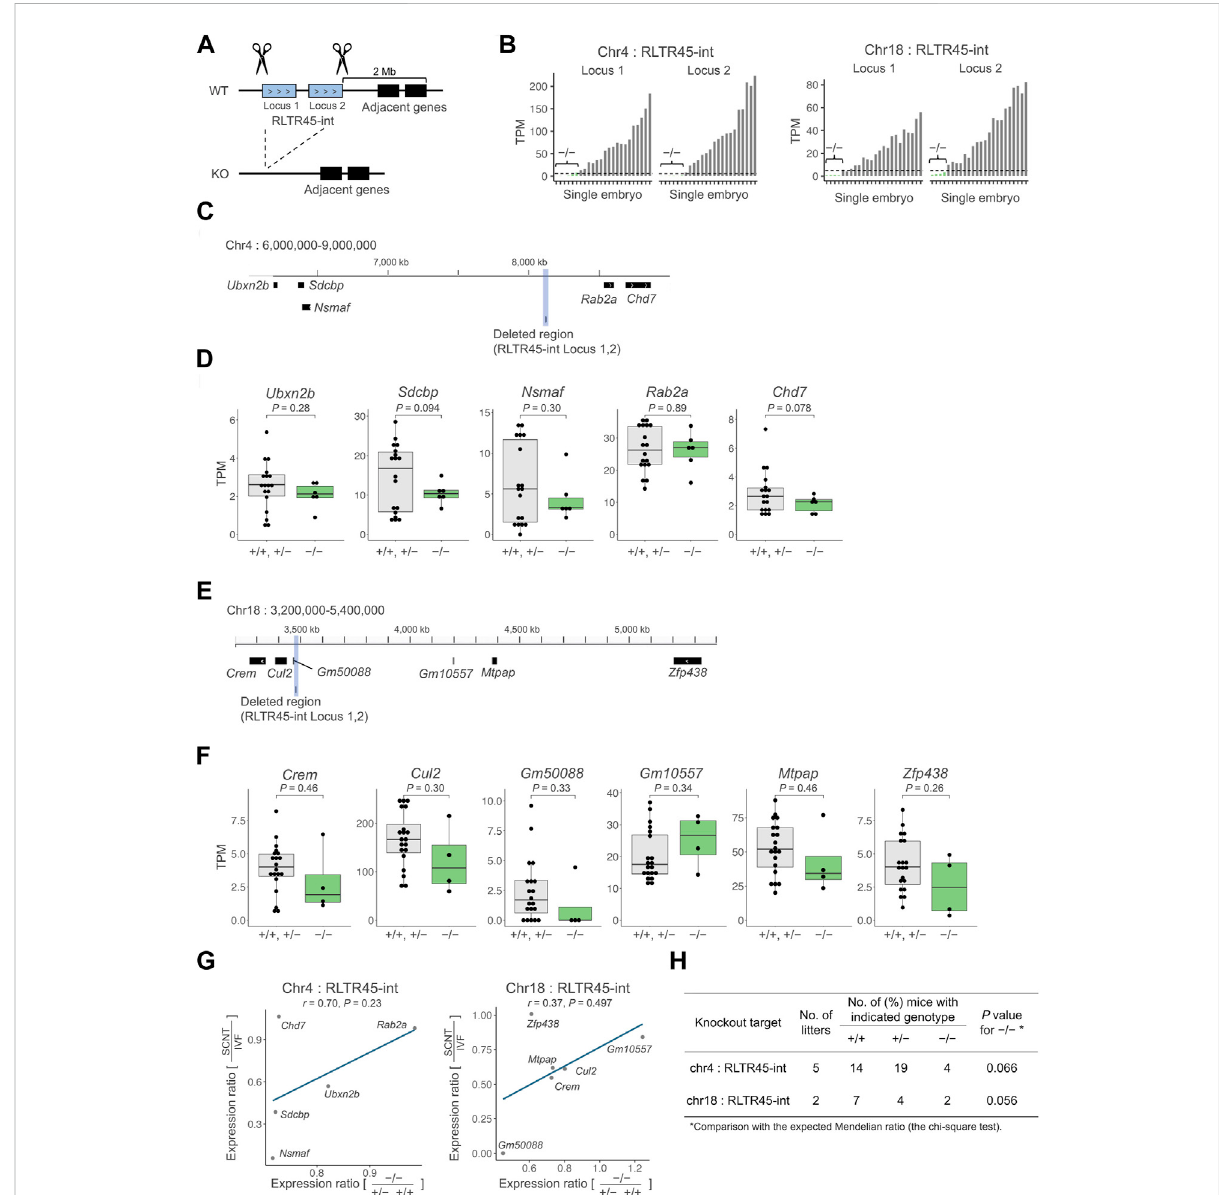
FIGURE 3 Deletion of SCNT-low and enhancer-like RLTR45-int loci caused decreased expressions of the adjacent genes. (A) Schematics of the experimentalapproach. Bothends ofatargetregionincludingtwoSCNT-low,enhancer-likeRLTR45-intlocion chromosome 4or18 werecutwith the gRNAs-Cas9 complex to delete the entire region (B) Bar graphs showing expressions of two targeted RLTR45-int loci on chromosomes 4 (left) and 18 (right) after CRISPR/Cas9-mediated knockout. Homozygous knockout embryos were determined based on the no or negligible expression levels (TPM < 5) of both RLTR45-int loci (depicted as “ − / − ” ). (C) Genome browser view showing the deleted region and its adjacent genes which are expressed in morulae on chromosome 4. The deleted region is highlighted in gray. (D) Box-and-whisker plots comparing the expressions oftheadjacentgenesonchromosome4inputativelyhomozygousknockout( − / − )embryosandotherembryos( +/+ , +/ − ). p valueswerecalculatedbya two-tailed t -test. (E) Genome browser view showing the deleted region and its adjacent genes which are expressed in morulae on chromosome 18. The deleted region is highlighted in gray. (F) Box-and-whisker plots comparing the expressions of the adjacent genes on chromosome 18 in putatively homozygous knockout embryos ( − / − ) and other embryos ( +/+ , +/ − ). p values were calculated by a two-tailed t -test (right). (G) Scatterplot showing correlation of the decreased expression ratios of adjacent genes in SCNT (vs. IVF) and homozygous knockout (vs. +/+ and +/ − ) embryos on chromosomes 4(left)and 18(right). Atentativeregression linewithoutstatisticalvaluesisshown because ofthesmallnumber ofsamples. (H) In vivo development of embryos treated with CRISPR/Cas9 targeting RLTR45-int loci on chromosome 4 or 18. Embryos were produced by IVF using heterozygousfemalesandmalesandtransferredintopseudopregnantfemales.LiveembryoswereretrievedatE12.5andgenotypedforthetargeting